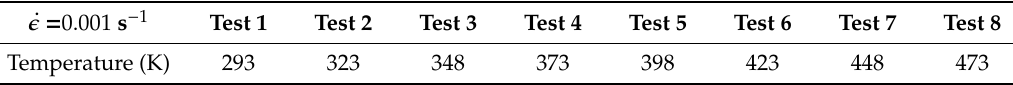
Table 3. Quasi-static test conditions for a constant strain rate (0.001 s − 1 ).